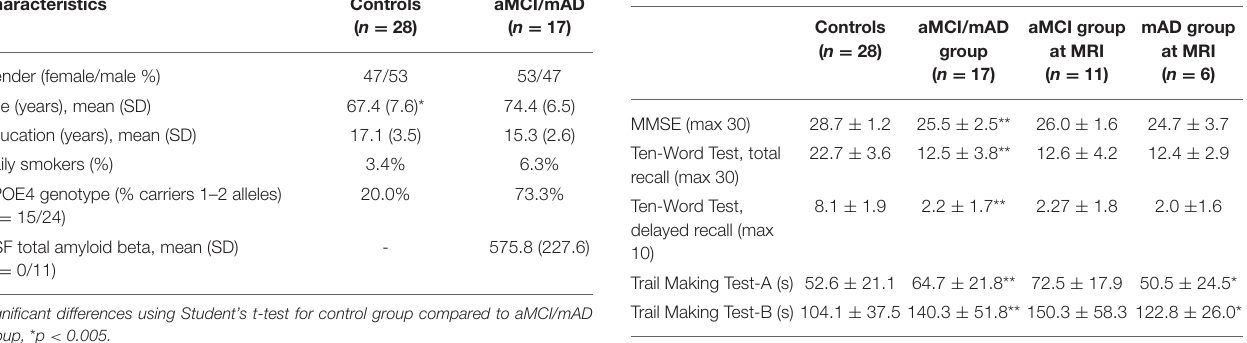
TABLE 2 | Performance of cognitive tests (mean ± SD) for the control group, combined aMCI/mAD group, and the aMCI and mAD groups separately.